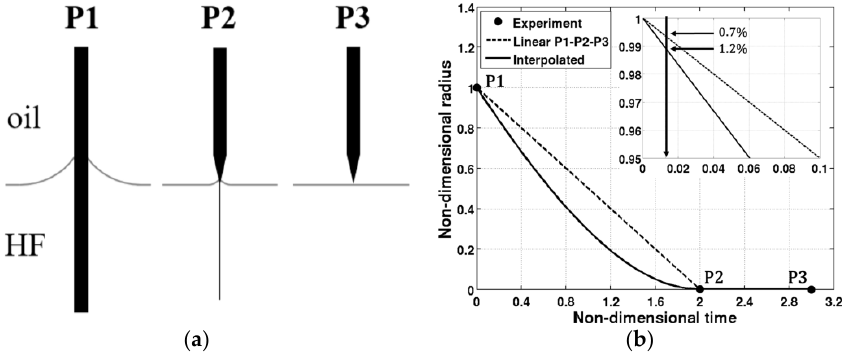
Figure 5. ( a ) Schematic of tip formation; ( b ) Evaluation of the representative mechanical-chemical etching rate for the TCN2